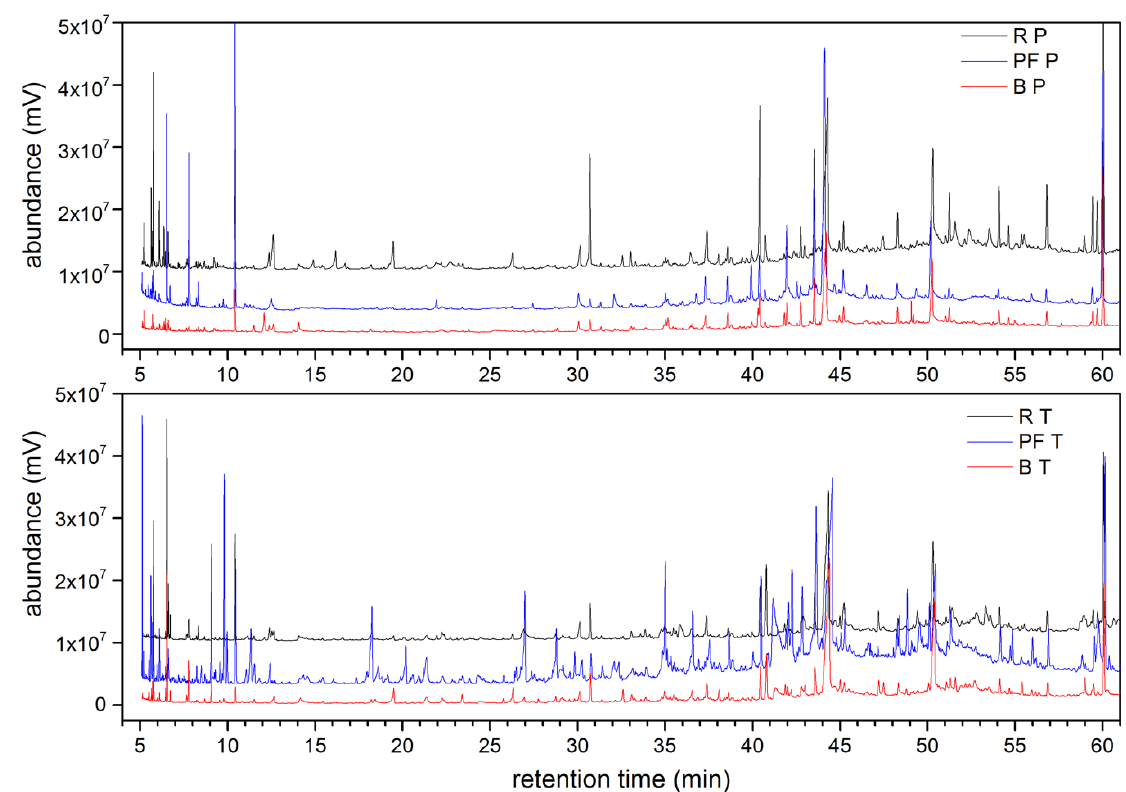
Figure 2. Chromatogram overlay of PET samples P ( Top ) and T ( Bottom ). R, PF, and B mean pellets, preforms, and bottles, respectively.